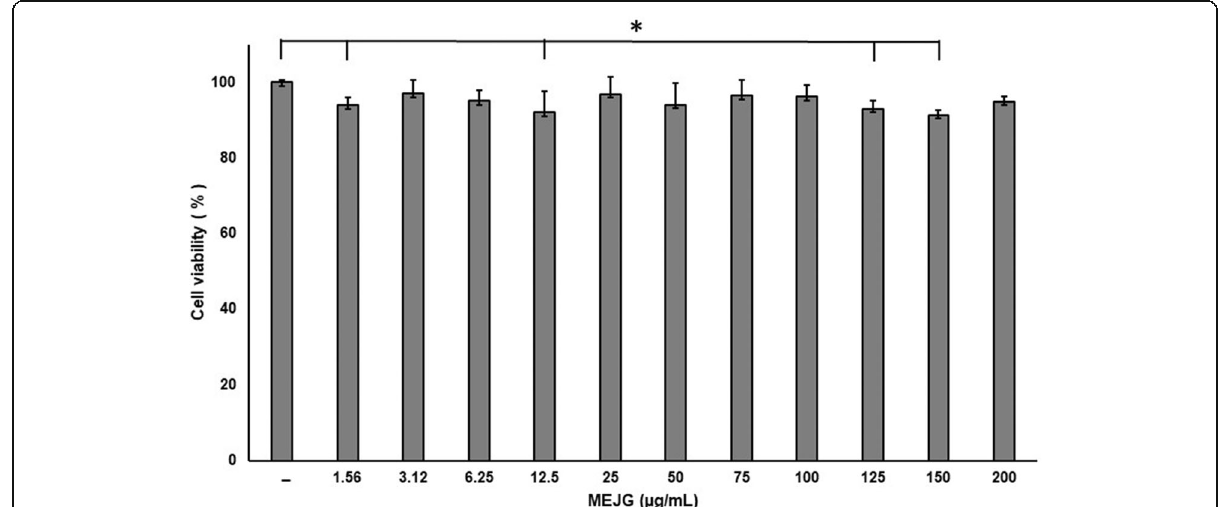
Fig. 2 Cell viability in macrophages. Cells were treated with MEJG at 1.56, 3.12, 6.25, 12.5, 25, 50, 100, and 200 μ g/ml, and the viability was determined by MTT assays. The results are expressed as the percentage of surviving cells relative to control cells. The data were obtained from three independent experiments and are expressed as the means ± SD * p < 0.5 ( n = 8)